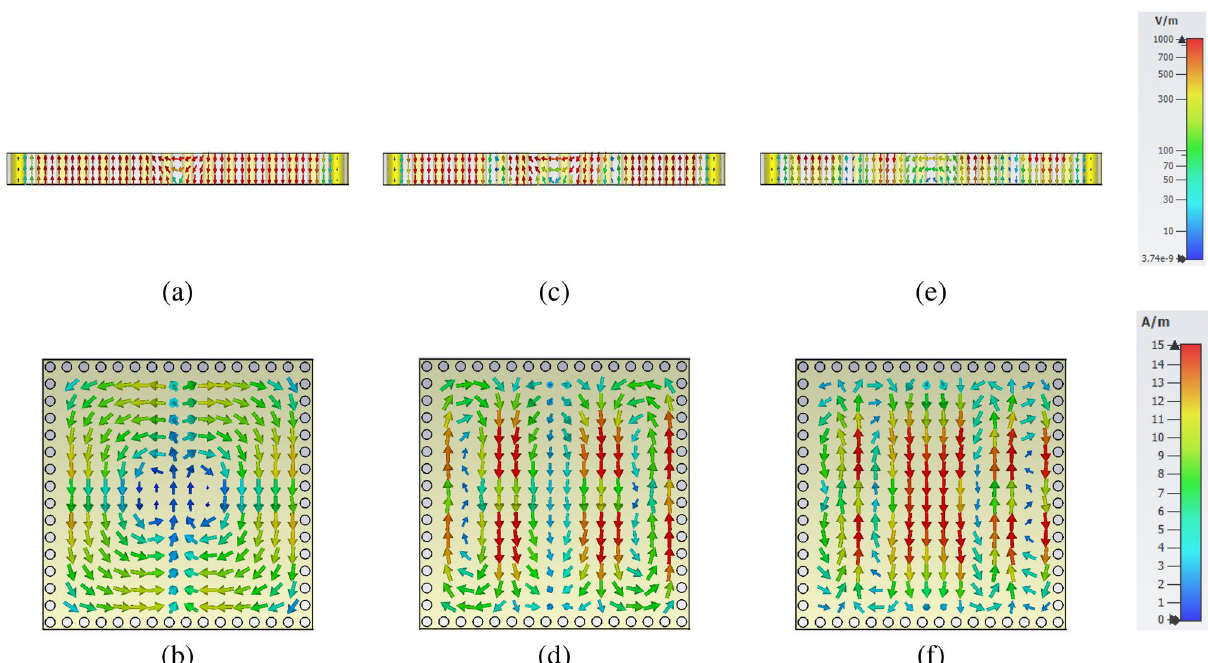
2.4 GHz Figure 6. Electromagnetic fields facing TM polarized incident waves ( a ) E-field distribution at f = 2.4 GHz ( TE 201 ), ( c ) E-field distribution at f 5 GHz (Hybrid mode ( TE 201 ) , b H-field distribution at f = = 5 GHz (Hybrid mode of TE 201 and TE 401 ) ( e ) E-field of TE 201 and TE 401 ) , ( d ) H-field distribution at f = 7.7 GHz ( TE 401 ) , ( f ) H-field distribution at f 7.7 GHz ( TE 104 ). This figures have been distribution at f = = created by CST Studio 2019 Version